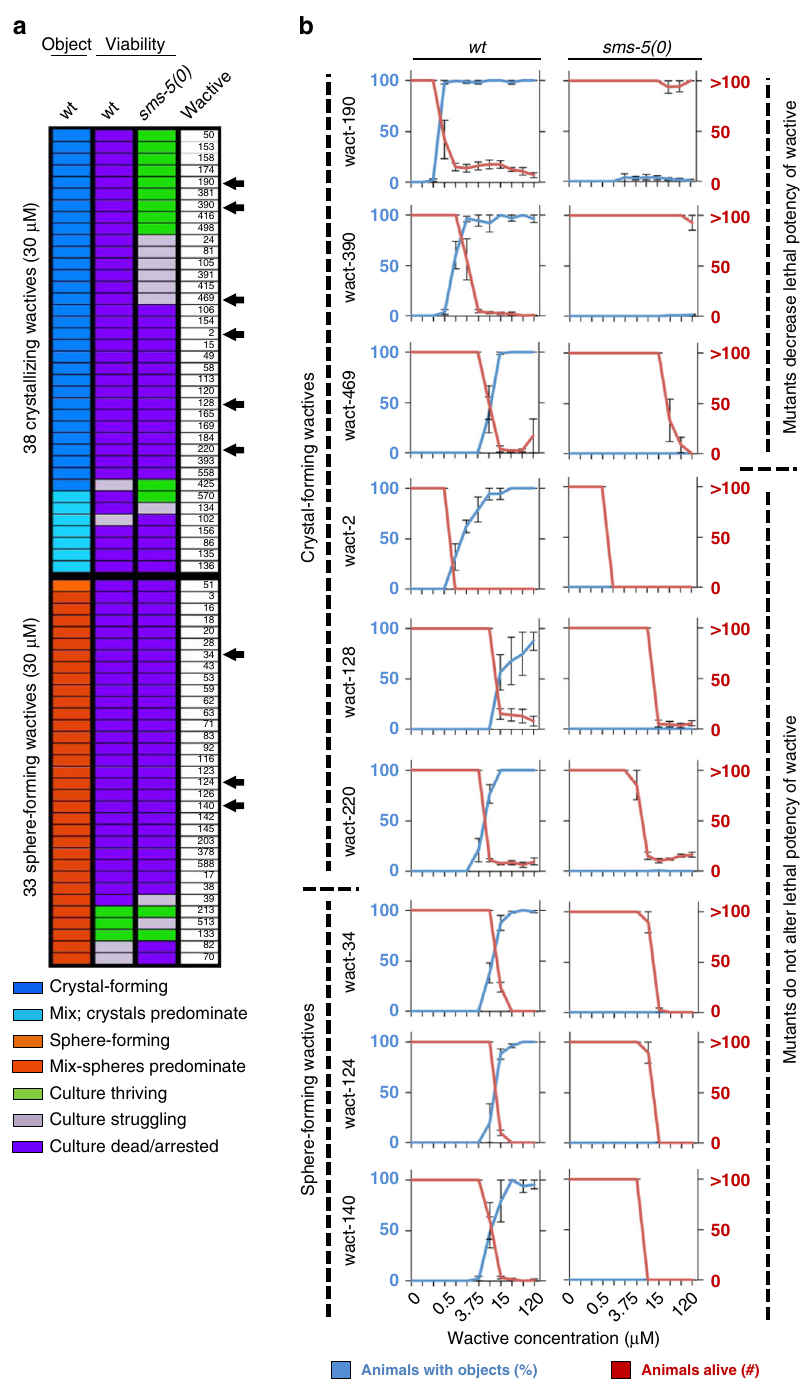
Fig. 8 A comparison of the lethality and object-forming capability of wactives in animals lacking SMS-5. a The behavior of molecules that form objects in at least 25% of the population are analyzed with respect to their lethal potency in wild-type and the sms-5(ok2498) deletion mutant. The wactive number is shown on the right and black arrowheads indicate the wactives analyzed in b . b . Dose – response analyses for select crystal and sphere-forming wactives in the indicated genetic background (indicated at the top of the two columns of graphs). Each of the wactives is analyzed over a twofold dilution series of concentrations (indicated at the bottom of the three columns of graphs). Wactive molecules are indicated on the left. The standard error of the mean is shown. Source data are provided in the Source Data fi